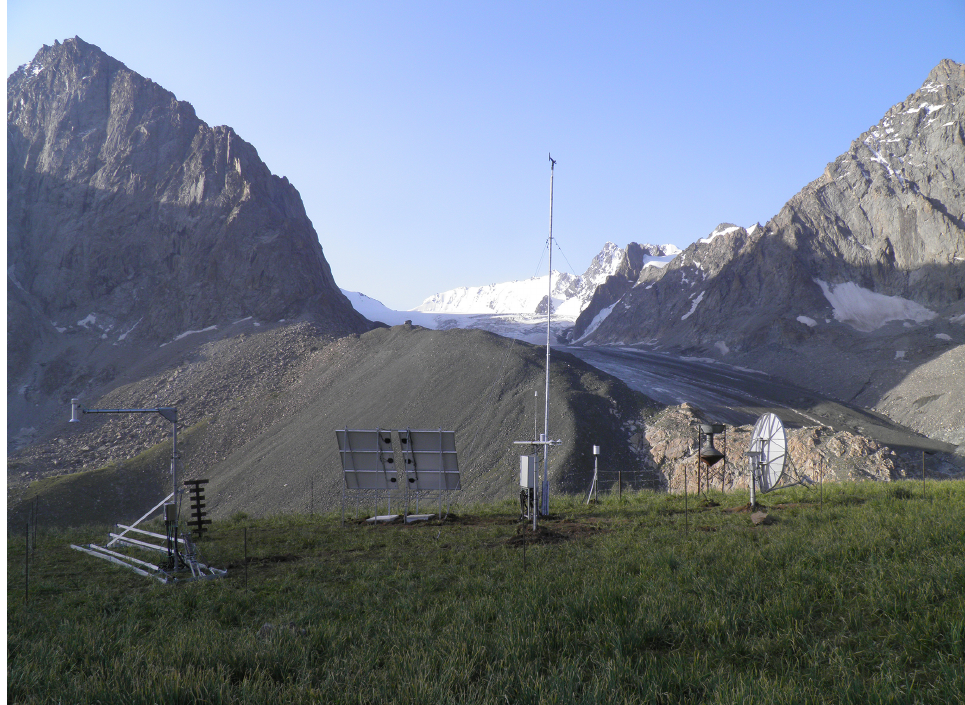
Figure 2. Station type one with meteorological sensors and a snow pack analyser (SPA, front left) at the station Golubin Glacier (GOLU).